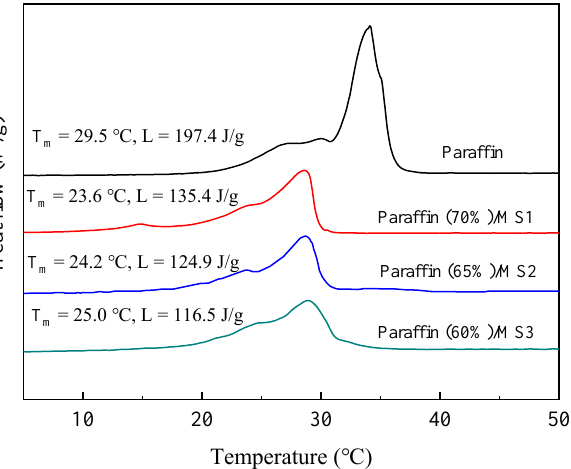
Figure 6. DSC curves of paraffin and paraffin/MS SS-PCMs with different MS pore diameters and maximum paraffin mass proportions of 70%, 65% and 60%. Table 2. Thermophysical properties of paraffin and paraffin/MS SS-PCMs.